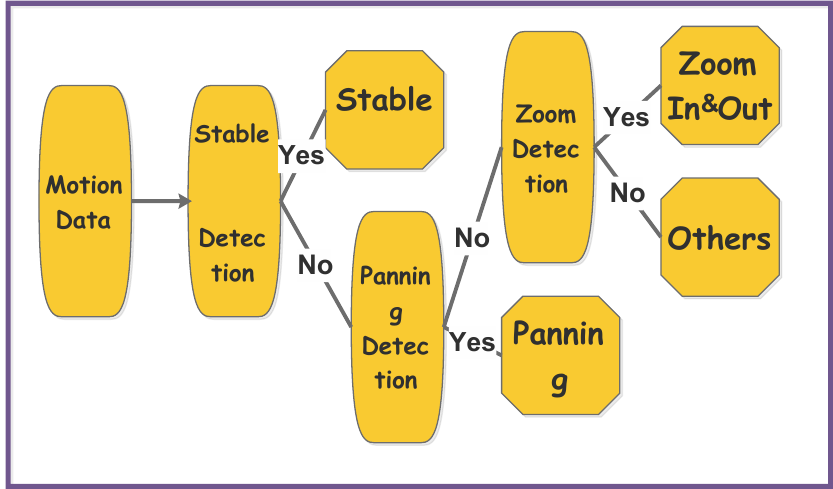
Figure 5. A decision tree model for global motion detection.